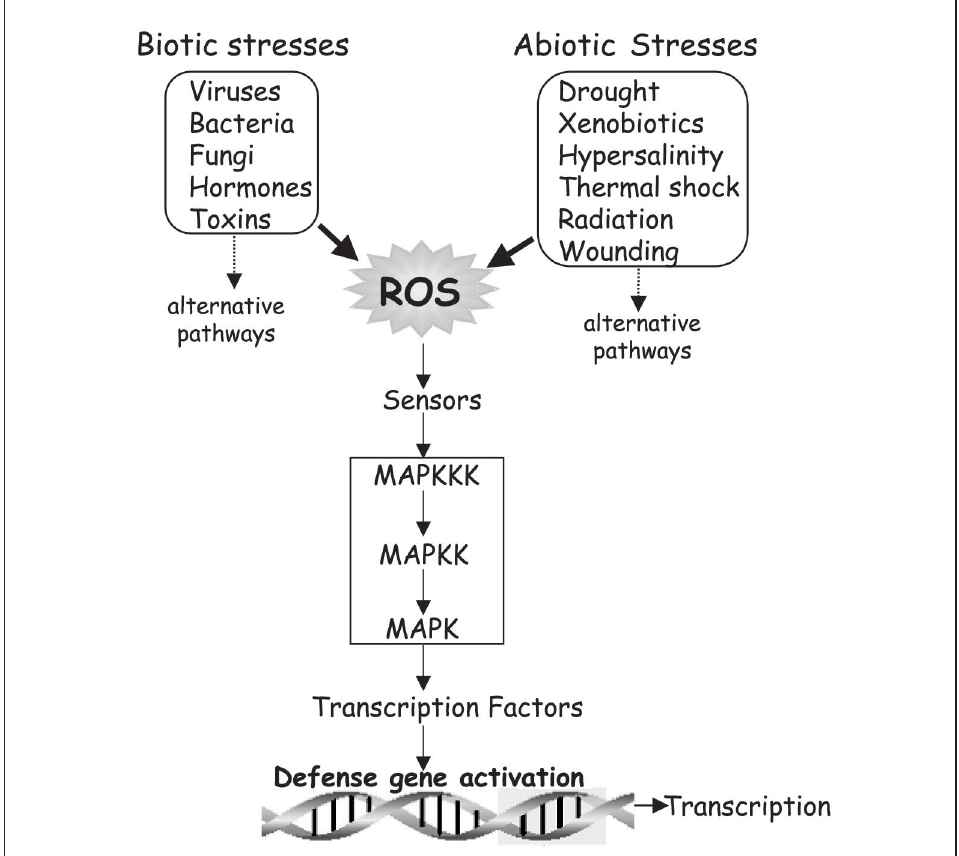
Figure 8. Schematic representation of the promoter region of each of the three catalase ( Cat ) genes of maize indicating the locations of the NF- κ B, ARE, AP-1, and ABRE motifs relative to the transcription start site (+1) of each gene. NF- κ B = nuclear factor κ B; ARE = antioxidant-responsive element: ABRE = abscisic acid-responsive element; AP-1 = activator protein-1.